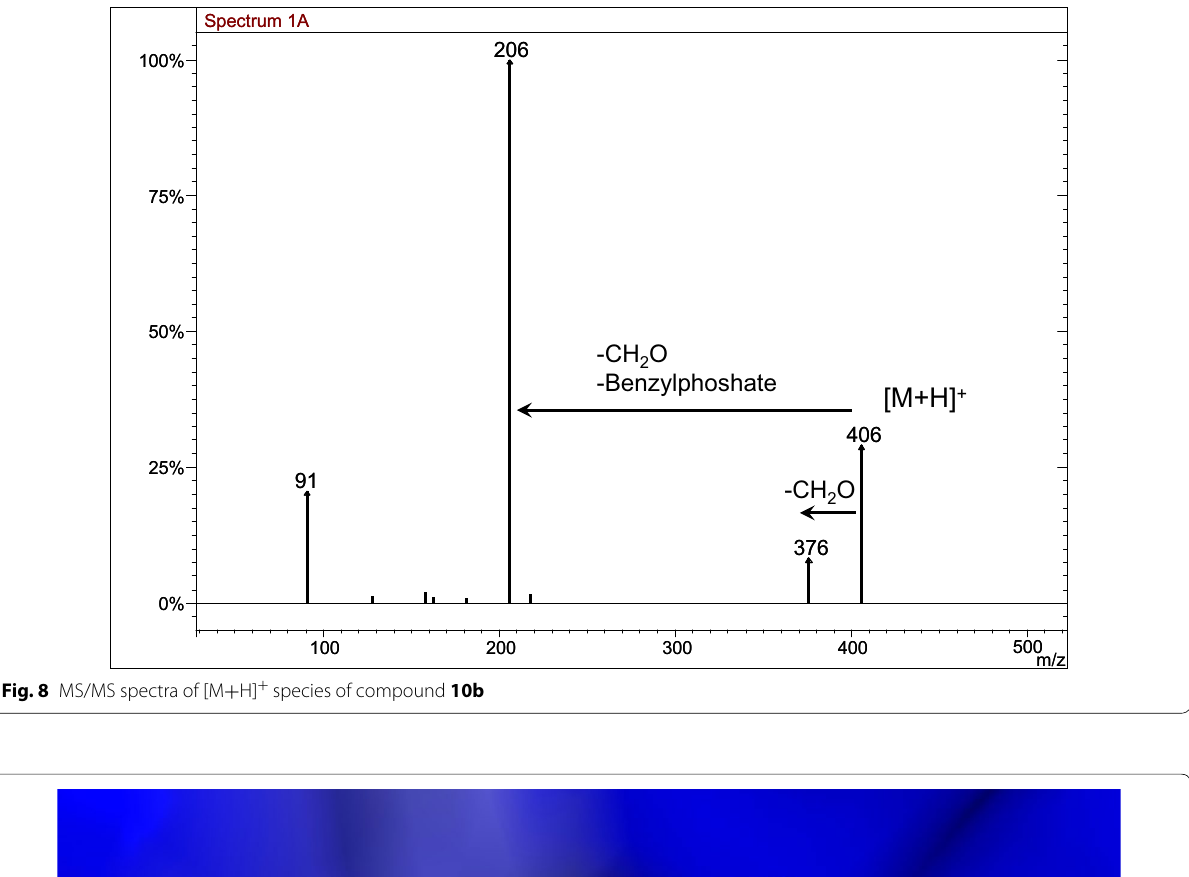
H] + species of compound 10b +